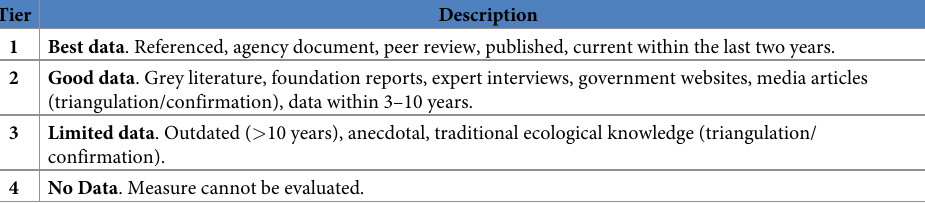
Table 3. Data quality scale applied to the assessment of each measure in the